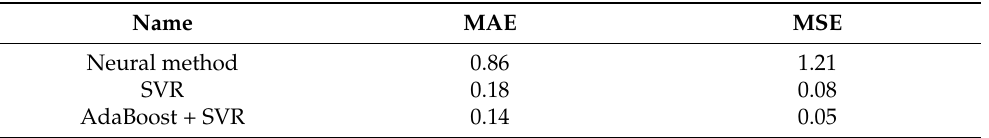
Table 6. Comparison of our SVM and AdaBoost + SVM results with the result of the